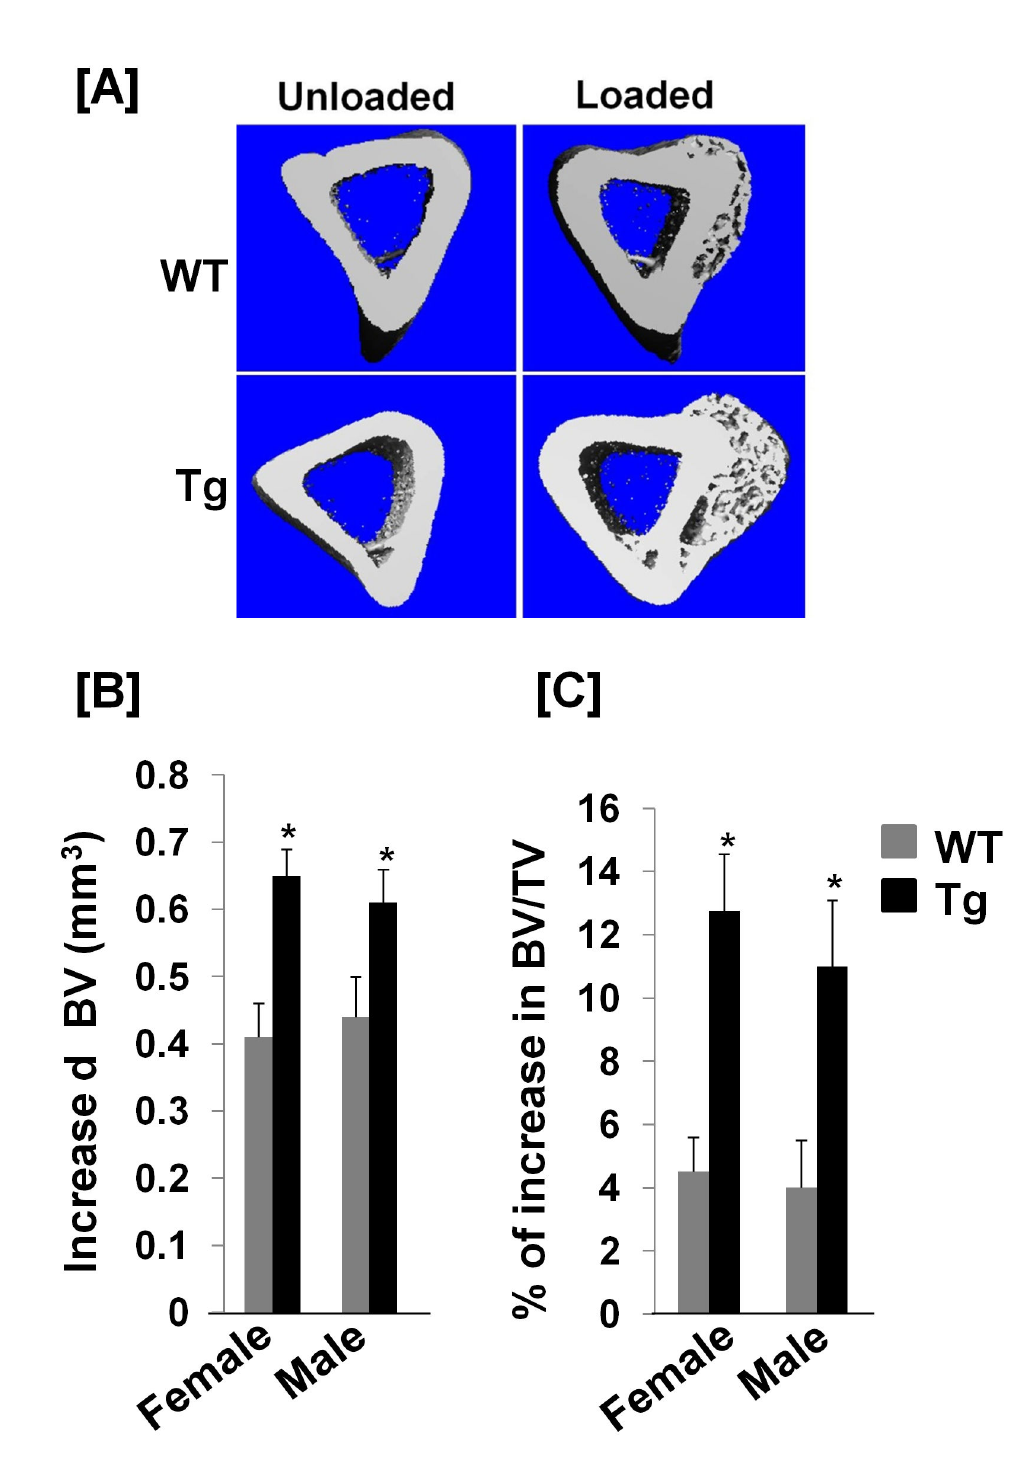
Figure 8. Overexpression of ephrin B1 in bone cells promotes a skeletal anabolic response to mechanical loading in transgenic mice. [A] Micro-CT images of the mid shaft of the tibias of12-week old WT and Tg male mice. [ B & C ] Quantitative data of increased total newly formed bone and BV/TV in response to mechanical loading. Data are the means ± SEM for N = 6 per group. A star represents statistical significance (P < 0.05) when compared to WT littermate controls. doi: 10.1371/journal.pone.0069051.g008 PLOS ONE |